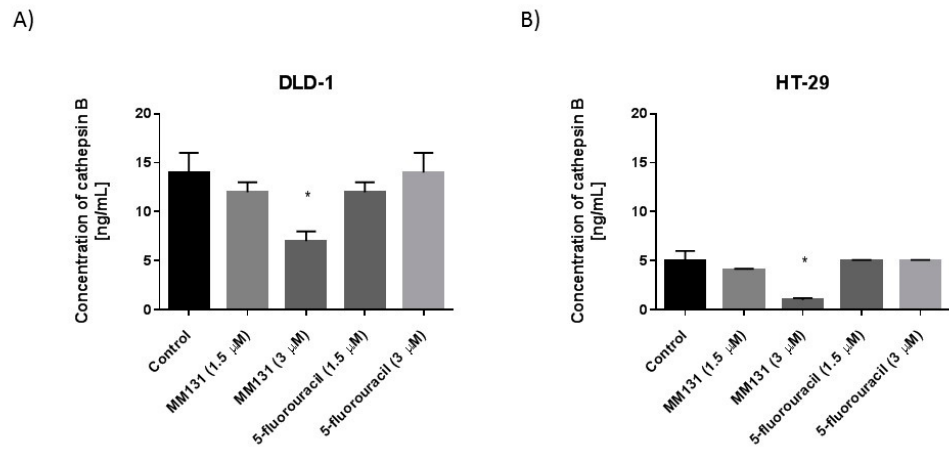
Figure 11. Quantification of cathepsin B by ELISA. Bar graphs demonstrating cathepsin B concentration in DLD-1 ( A ) and HT-29 ( B ) colorectal cancer cells after 24 h of incubation with MM131 and 5-fluorouracil. n = 3 in duplicates, * p < 0.05 versus respective control group.